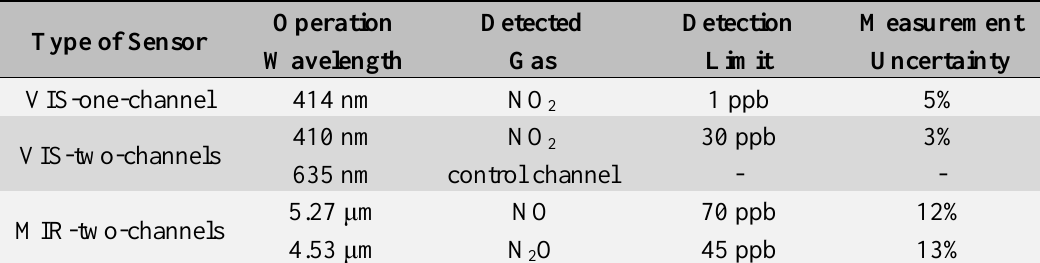
Table 4. The test results of our